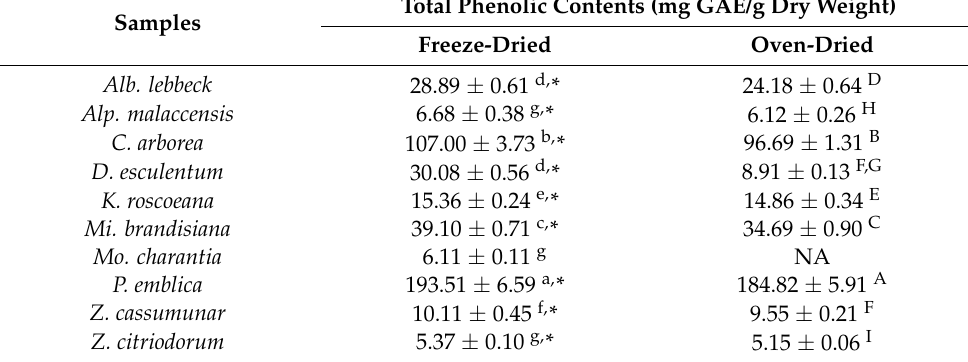
Table 2. Total phenolic contents (TPCs) of 10 indigenous plant extracts prepared from freeze-drying and oven-drying